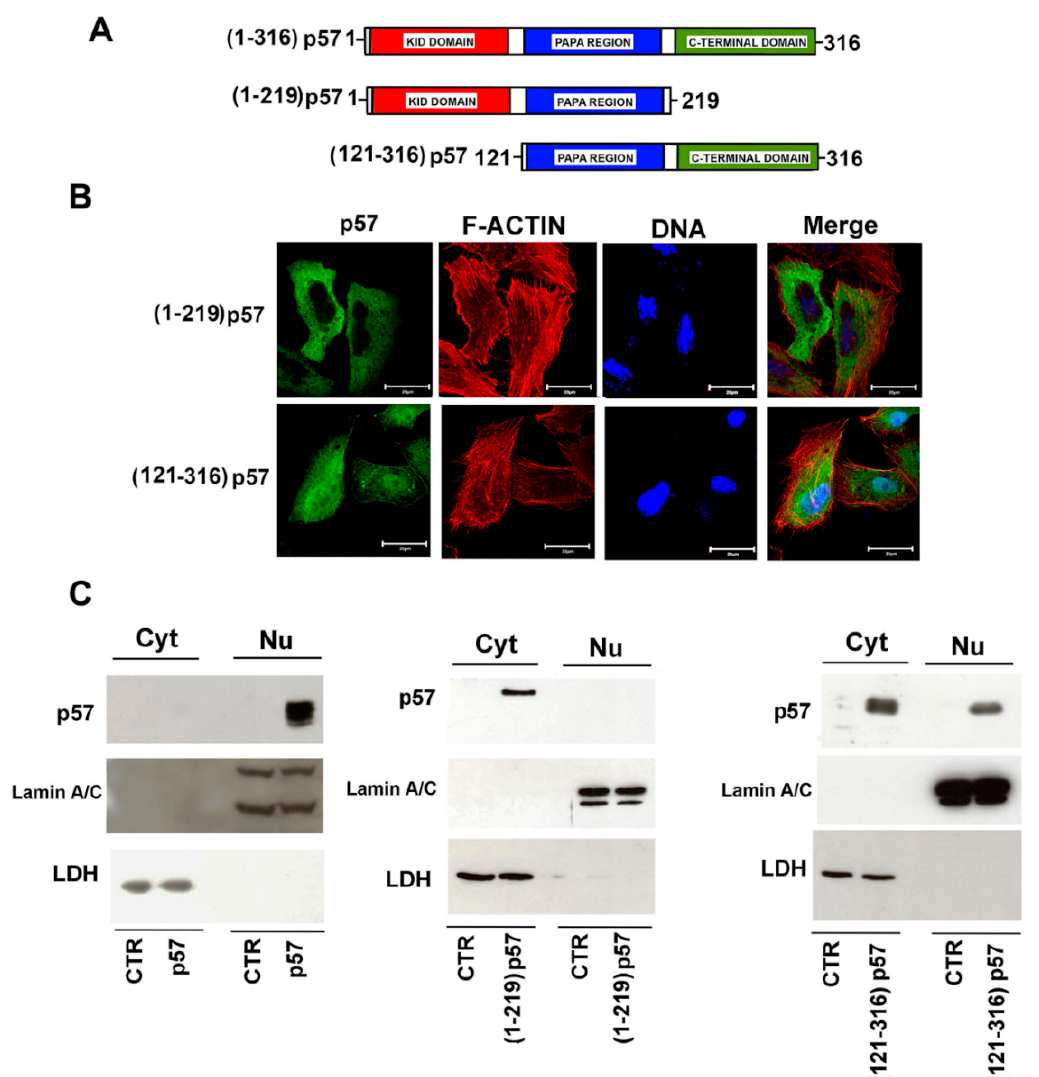
Figure 3. Nuclear localization of p57 is dependent on the C-terminal domain. ( A ) Schematic representation of the FL WT-p57 and the two N-terminal [(1–219)p57] and C-terminal [(121–316)p57] constructs. ( B ) The cellular localization of the exogenously expressed protein fragments was investigated using immunofluorescence as described in Figure 2B. Representative immunofluorescence images of cells transfected with the plasmids encoding the N-terminal and C-terminal p57 fragments were reported. p57 (green), DNA (blue), and F-ACTIN (red). Scale bar 20 µ m. For further details, refer to the Materials and Methods Section. ( C ) WB analysis of the cytosolic and nuclear content of p57 in HepG2 cells after 24h of transfection with the plasmids encoding FL WT-p57 (p57) and the two fragments (1–219)p57 and (121–316)p57. Lamin A/C and LDH were analyzed to confirm the proper separation of nuclear and cytosolic fractions and as control for equal protein